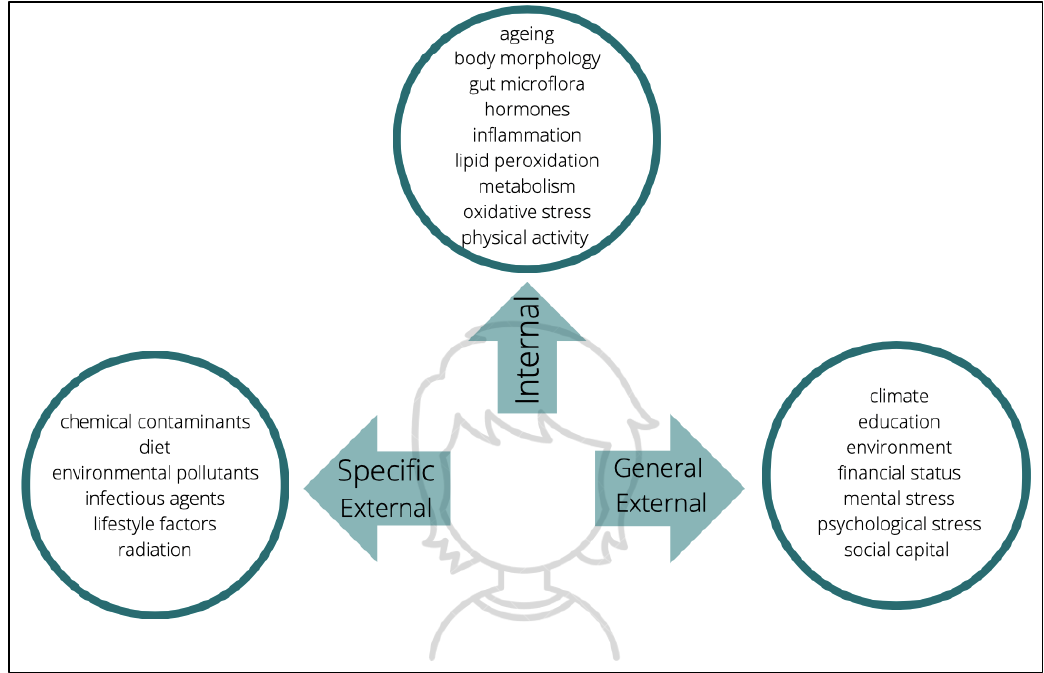
Figure 1. Three domains of exposome with narrow examples underlying each domain. Graphical diagram was adopted from [18] with permission from Oxford University Press, 2022.